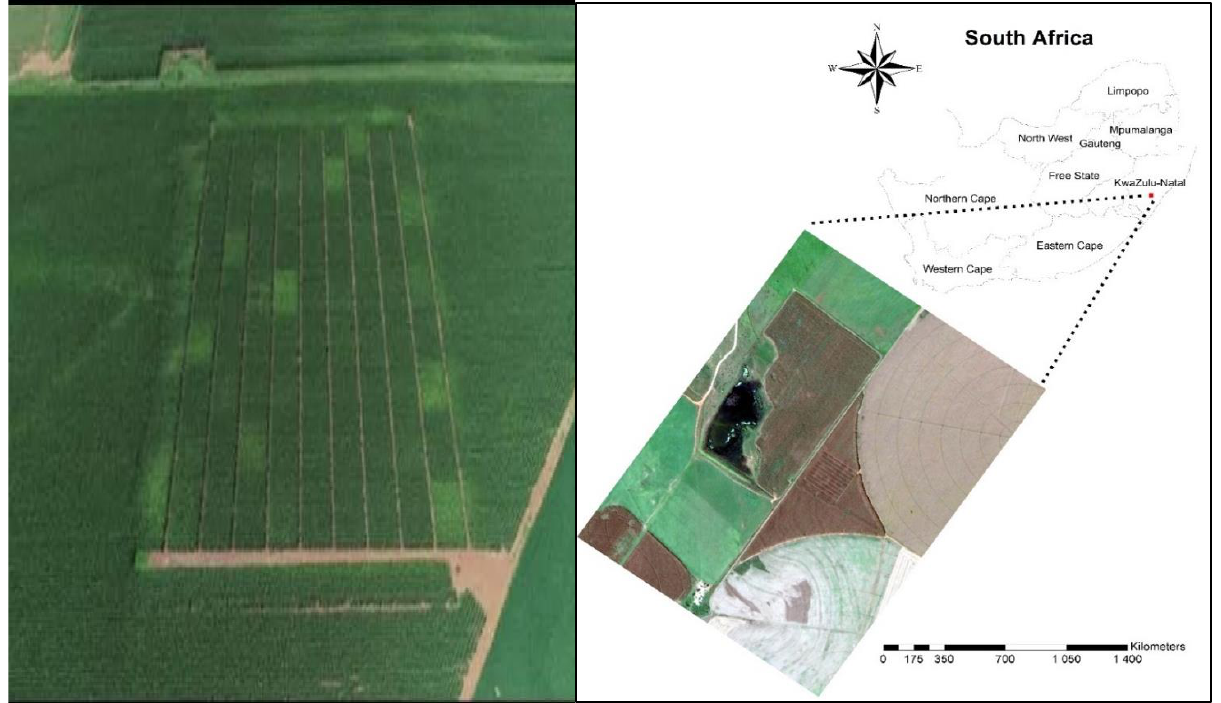
Figure 1. The location of the study area (28°55 ′ 26.83 ″ S, 29°33 ′ 38.64 ″ E, 1038 m above sea